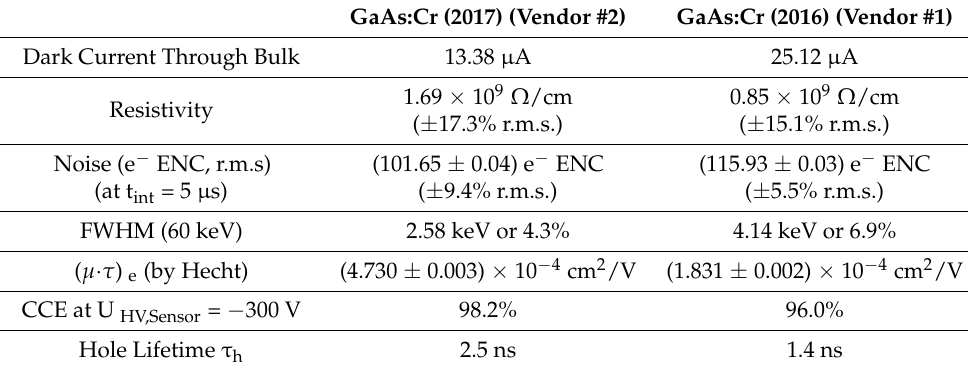
Table 3. Summary of the characterization results from the GaAs:Cr sensors based on LEC-grown wafers from different suppliers. The measurements have been performed under their standard operating parameters of T = +15 ◦ C and a sensor bias voltage of U Sensor = − 300